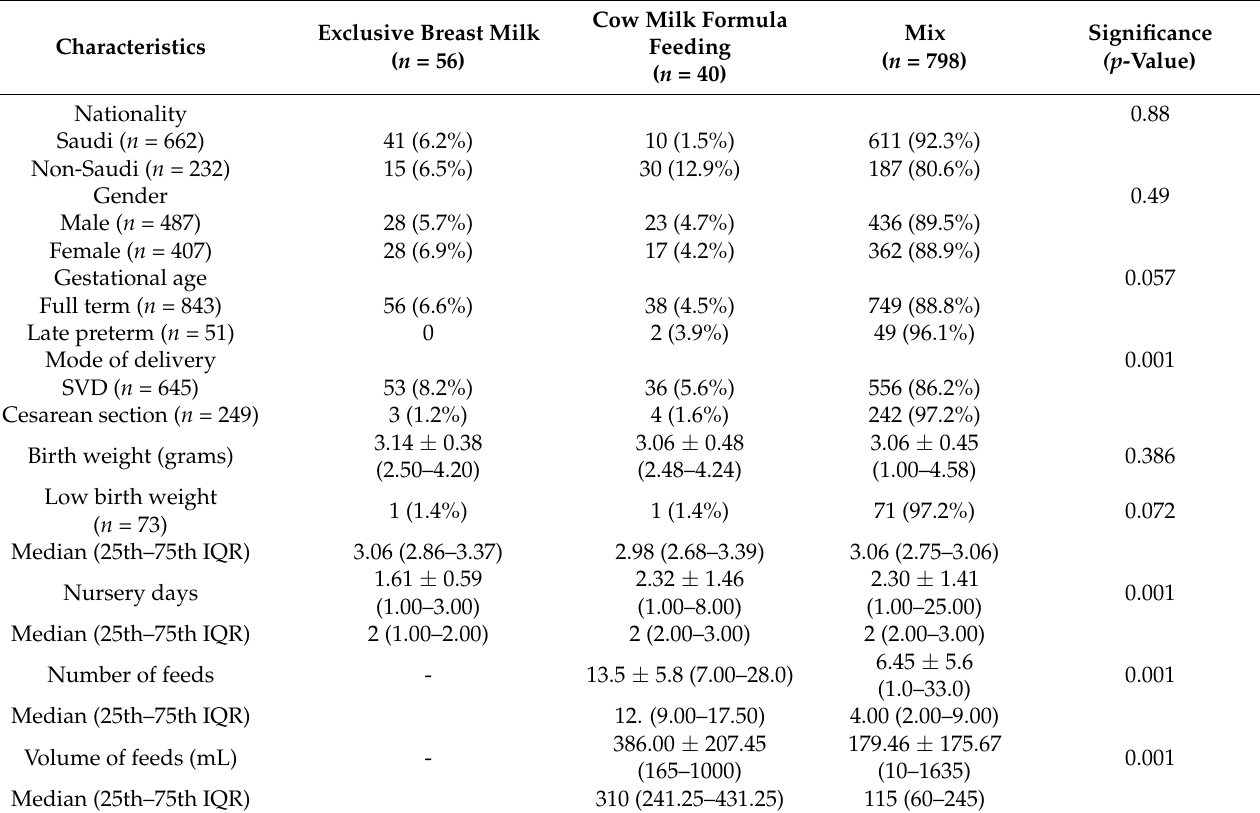
Table 2. Characteristics of the newborns according to type of feeding.